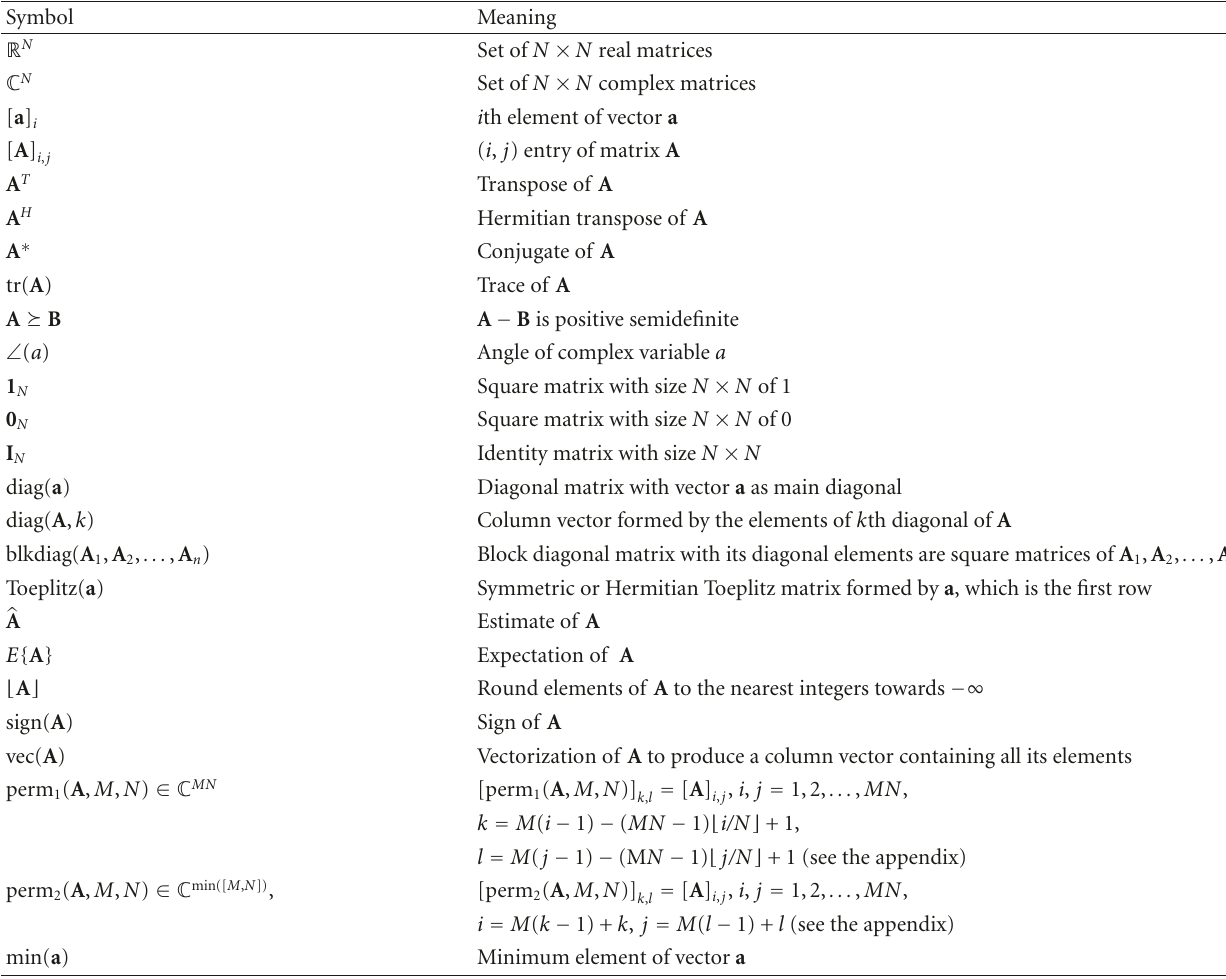
Table 1: List of